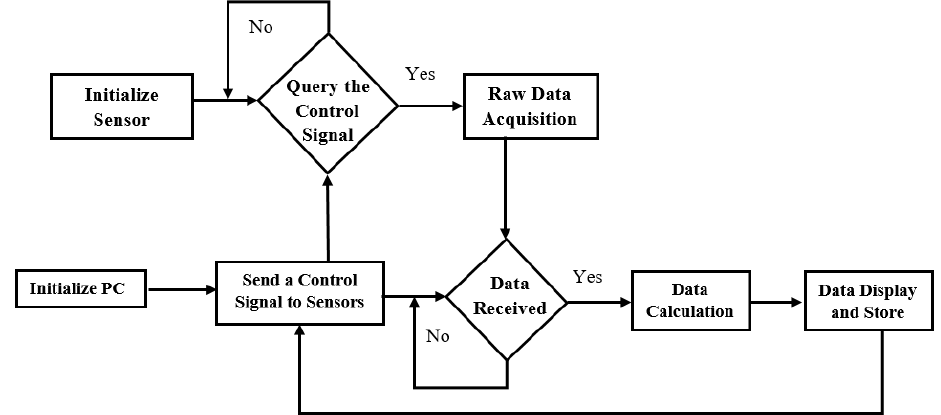
Figure 12. Flow chart to explain sensor data acquisition system layout.